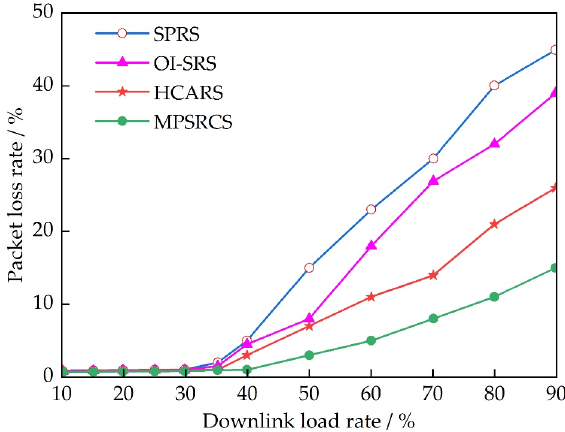
Figure 15. Comparison of the packet loss rate under different downlink load rates.